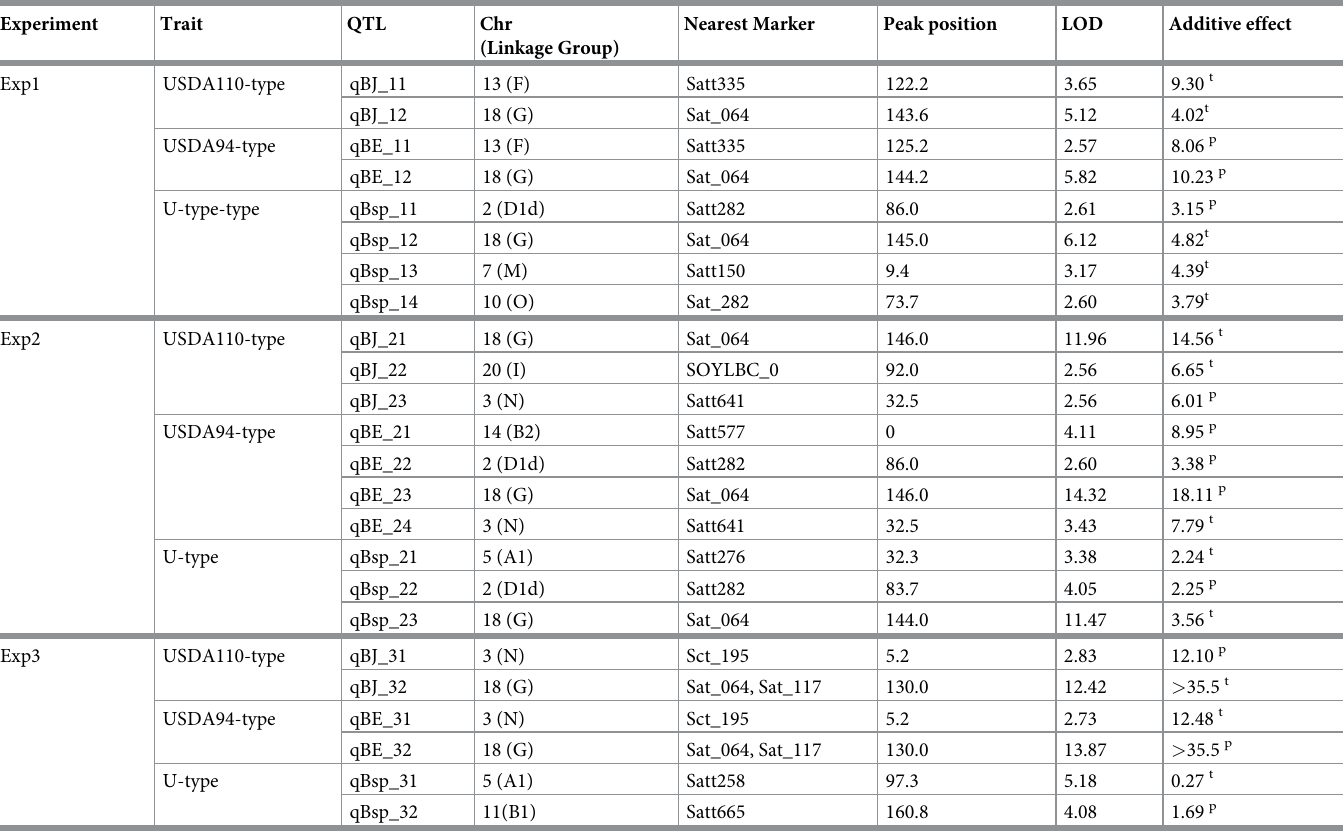
Table 2. Identified QTLs of B . japonicum , B . elkanii , rhizobiumsp . in the PT-RIL population from three independent experiments.